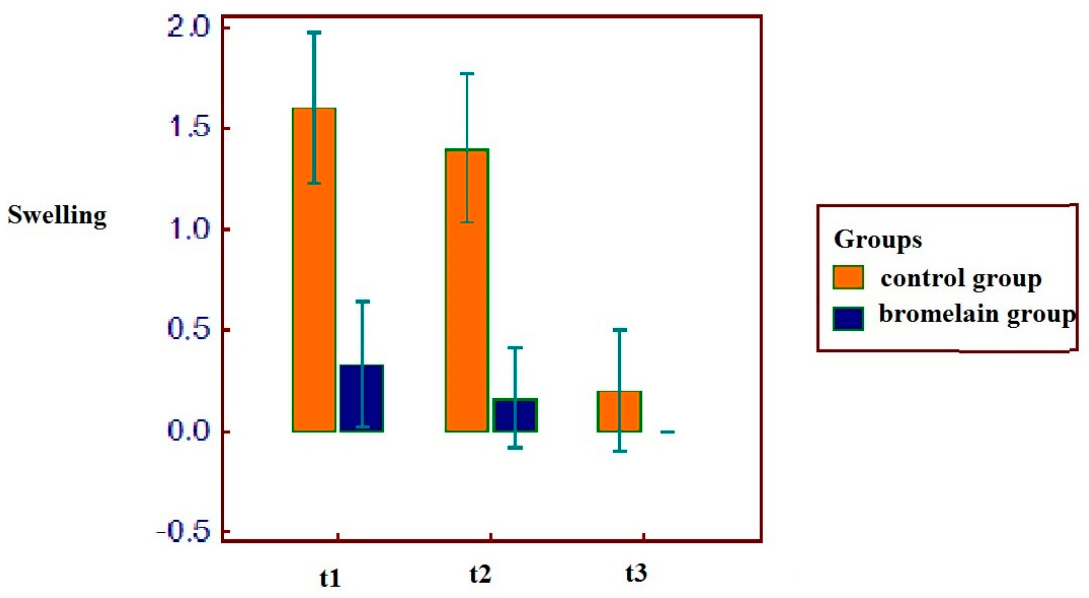
Figure 6. Decrease of swelling in all patients. Lower results are observable in patients with bromelain prescription.